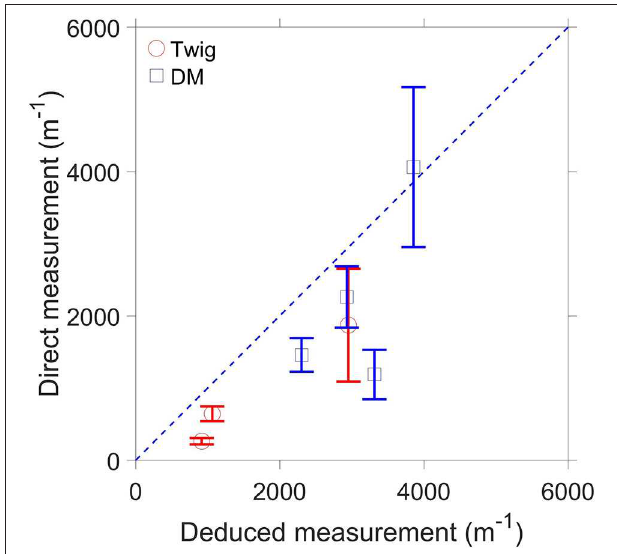
FIGURE 11 | Comparison of the direct measurement and the measurement through pressure gradient of the specific area under the different particle size. DM, decomposing